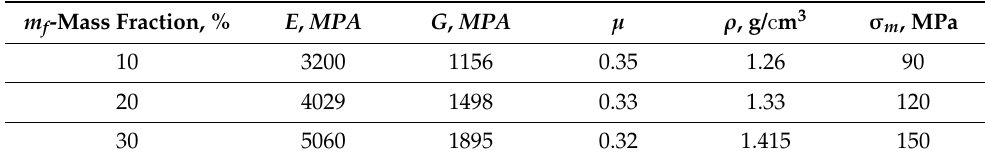
glass fibers in the volume).